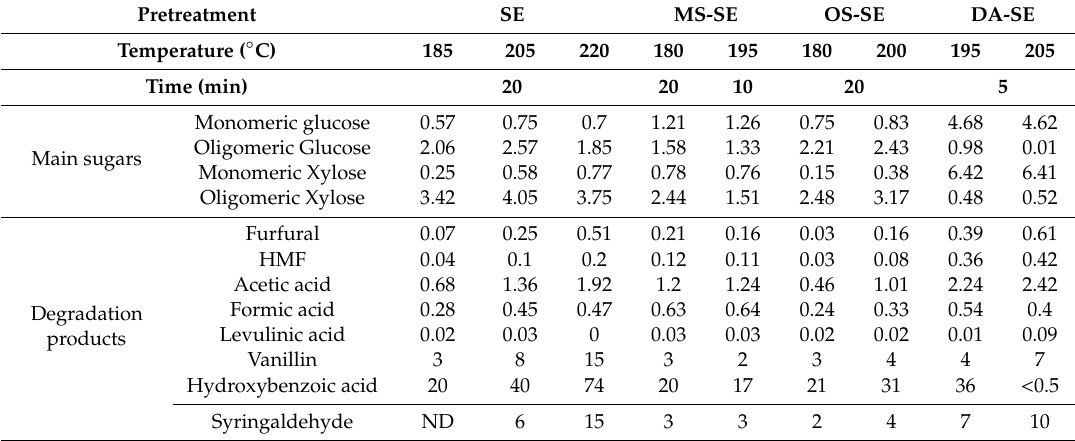
Table 3. Composition of liquid fraction (prehydrolyzated). Data are expressed as g per 100 g dry MFGW, except for vanillin, hydroxybezoic acid, and syringaldehyde, which data are expressed as mg per 100 g dry